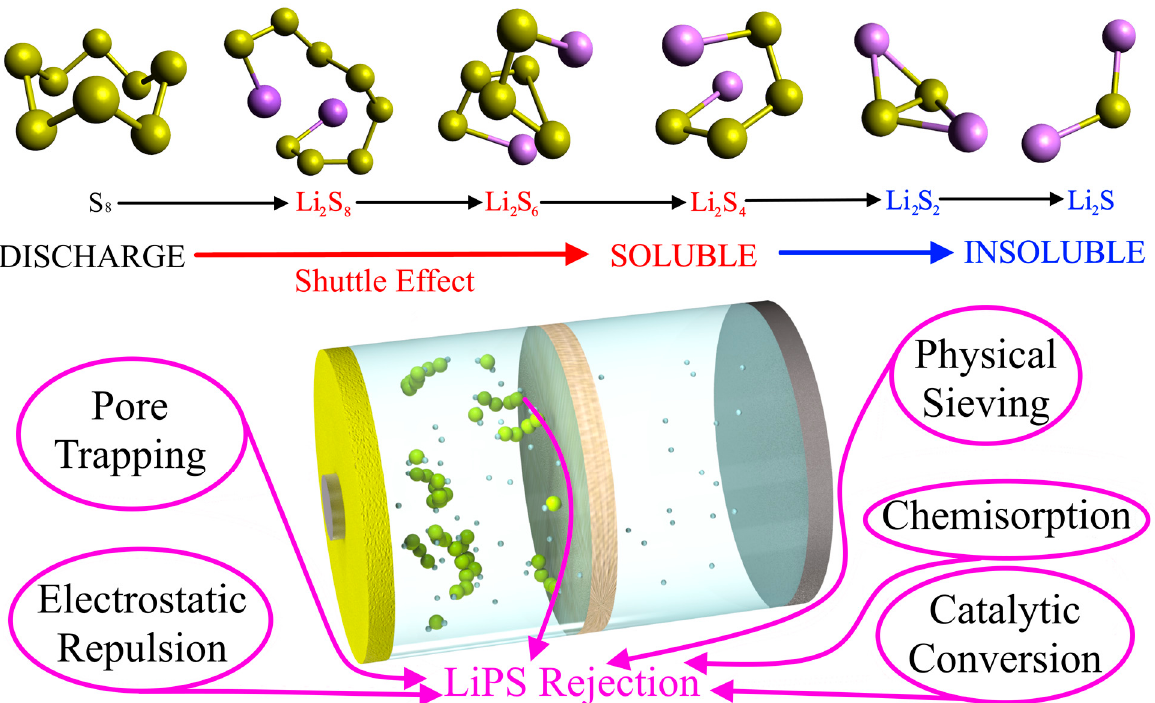
Figure 2. Schematic diagram showing the conversion of S 8 to Li 2 S with intermediate LiPSs during LSB discharge (Top). The insolubility/solubility of the LiPSs is noted by red/blue colors. The main LiPS rejection mechanisms employed by NF separators.